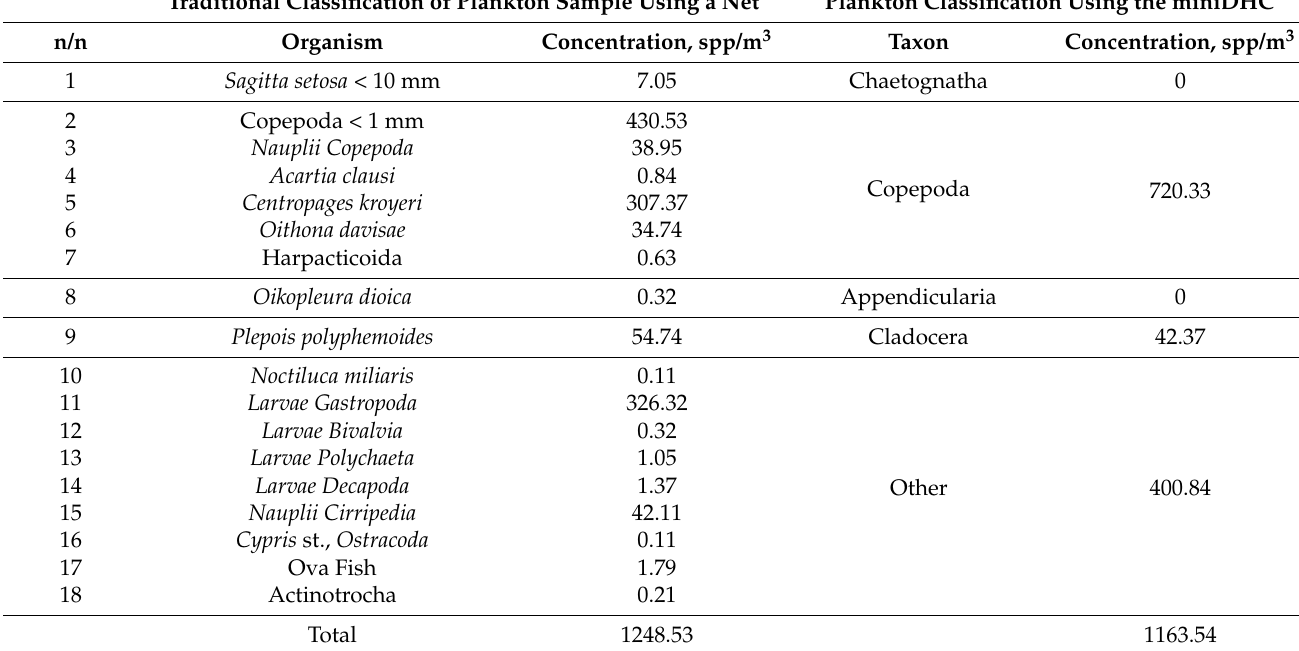
Table 4. Marine data for comparison of plankton measurements with average at the same maximum depth 7 m Traditional Classification of Plankton Sample Using a Net Plankton Classification Using the miniDHC